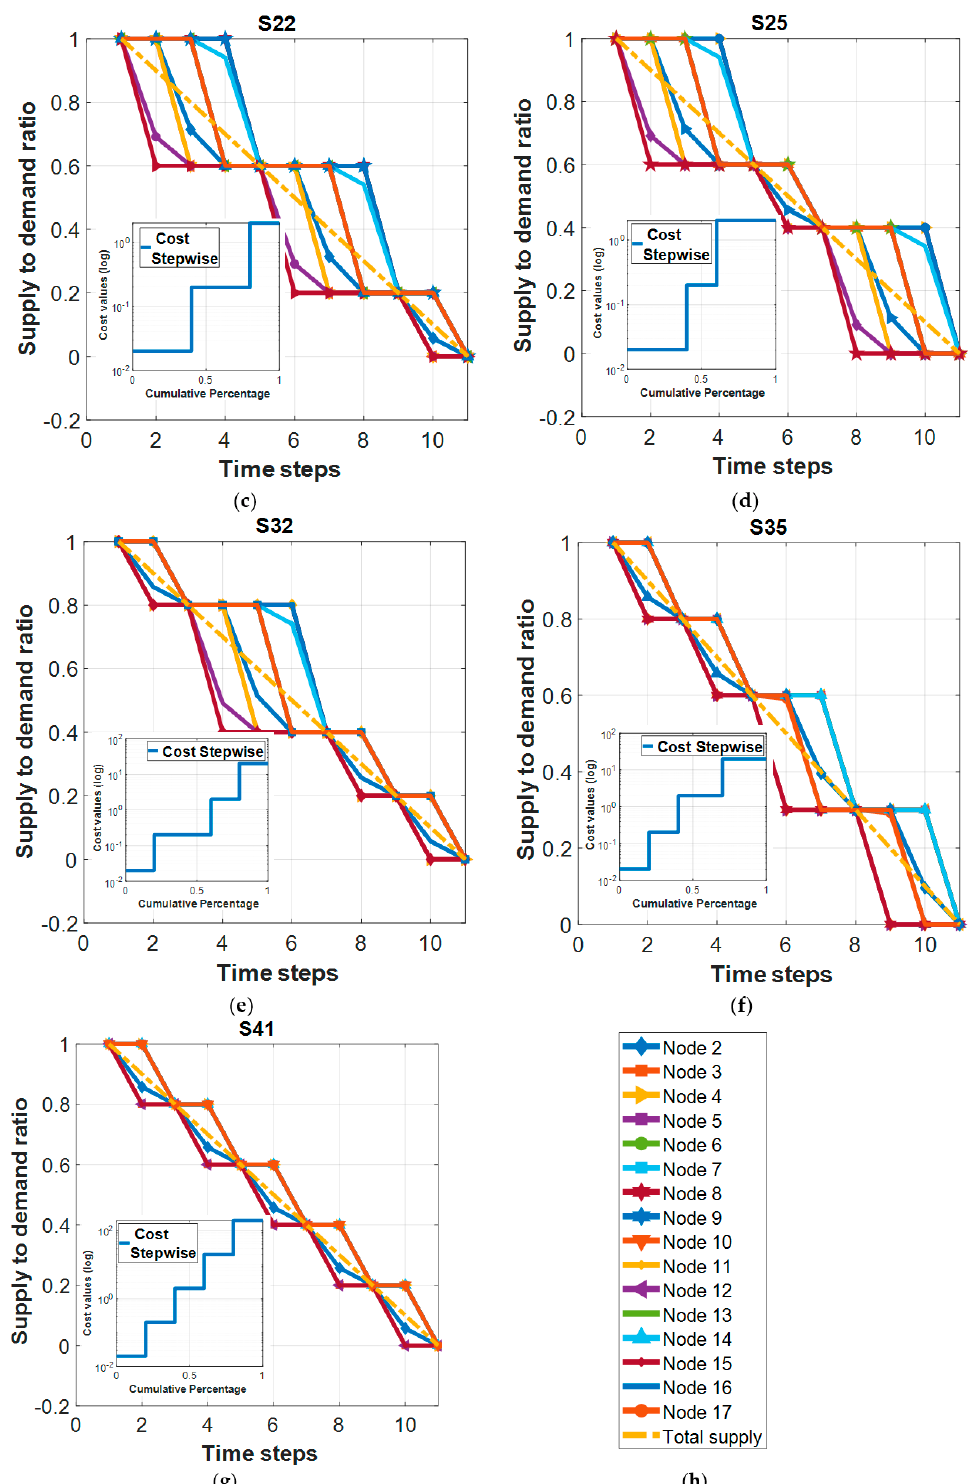
Figure 5. Results for different cost profiles/scenarios in Table A1, when the total electricity supply decreases by 10% per hour. The large graphs show the ratio of supply to demand for each node; small graphs—the corresponding cost profiles: ( a ) S14: cost profile is [0.4, 0.6]; ( b ) S15: cost profile is [0.2, 0.8]; ( c ) S22: cost profile is [0.4, 0.4, 0.2]; ( d ) S25: cost profile is [0.4, 0.2, 0.4]; ( e ) S32: cost profile is [0.2, 0.4, 0.2, 0.2]; ( f ) S35: cost profile is [0.2, 0.2, 0.3, 0.3]; ( g ) S41: cost profile is [0.2, 0.2, 0.2, 0.2, 0.2]; ( h ) The legend of all